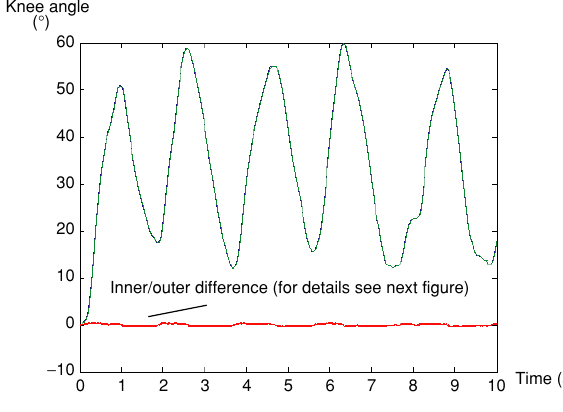
Figure 24 Response of the left knee joint. Figure 25 Angle difference between the inner exoskeleton and the LEE.